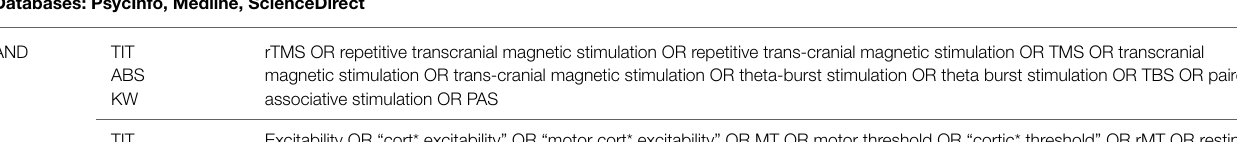
TABLE 1 | Search strategy for identification of relevant publications. Databases: PsycInfo, Medline, ScienceDirect